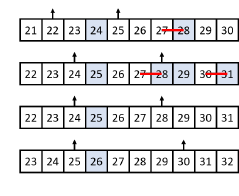
Figure 13: S 4 i +9